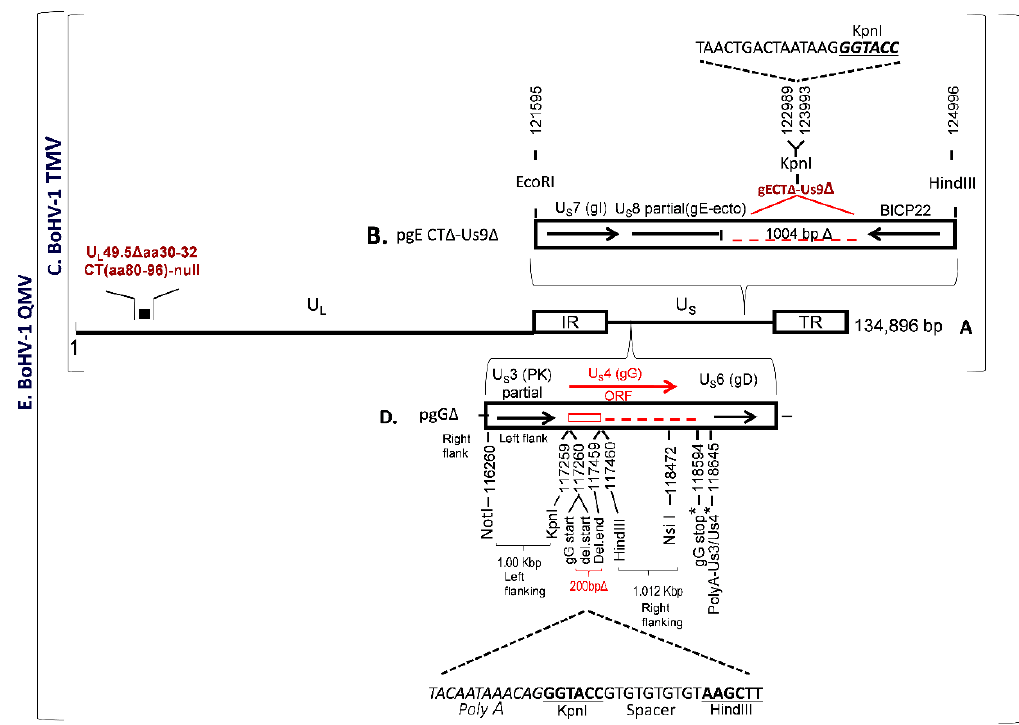
Figure 1. Schematic showing genomic configuration of BoHV–1 TMV constructed previously and the strategy of BoHV–1 gG gene deletion to generate a BoHV–1 QMV vaccine vector. ( A ) Schematic of BoHV–1 U L 49.5Δ30–32 CT–null virus backbone [14]. U L = unique long region; U S = Unique short region; I R = Internal repeat region and T R = Terminal repeat region. ( B ) Plasmid construct pgE CTΔ–Us9Δ used to introduce CTΔ–Us9Δ in the BoHV–1 U L 49.5Δ30–32 CT–null virus backbone ( A ) to generate a BoHV–1 triple mutant virus (BoHV–1 TMV) [28]. ( C ) Genomic configuration of BoHV–1 TMV. ( D ) Plasmid construct used to incorporate gG deletion in the BoHV–1 TMV to generate BoHV–1 QMV. Arrows indicate the direction of the corresponding open reading frame (ORF) and ( E ) Genomic organization of BoHV–1 QMV. Nucleotide numbers correspond to GenBank accession # JX898220.